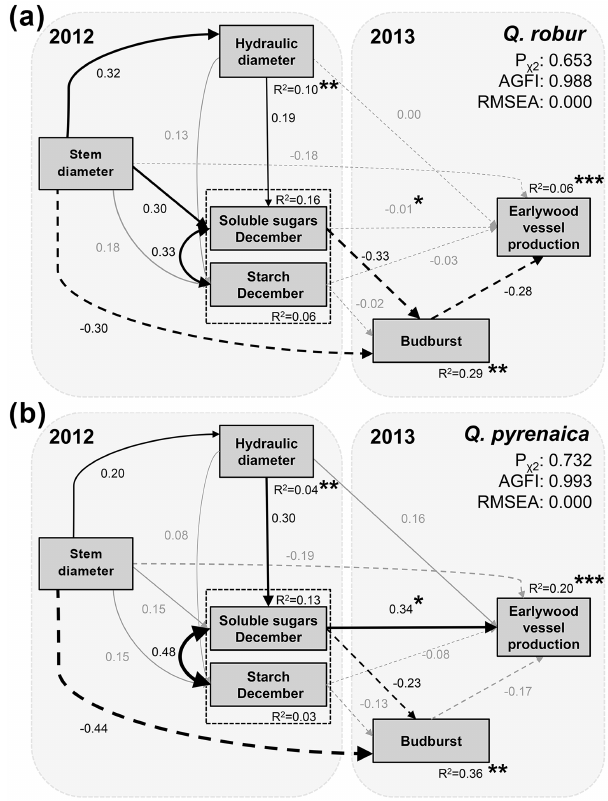
Figure 6. Structural equation models fitted for (a) Quercus robur ( N = 120) and (b) Q. pyrenaica ( N = 120). Variables of the con- ceptual model are stem diameter, hydraulic diameter in 2012, sol- uble sugars and starch concentrations in December 2012, budburst date, and earlywood vessel production (number of vessels) in 2013. Explained deviances of endogenous variables are shown near the boxes. Solid black (positive effects) and dashed (negative effects) arrows denote significant relations, while non-significant relations are shown as grey coefficients and arrows. The χ 2 test, the ad- justed goodness of model fit index (AGFI), and the root mean square error of approximation (RMSEA) are shown for each model. Asterisks indicate paths or error values significantly different be- tween the models of both species. ∗∗∗ P ≤ 0.001, ∗∗ P ≤ 0.01, and ∗ P ≤ 0.05.